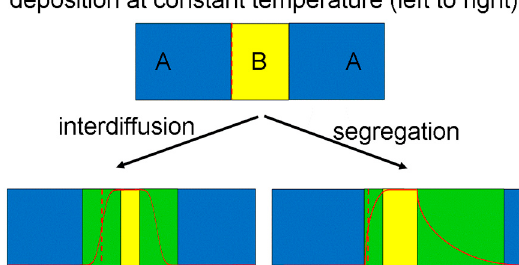
Figure 4. Sketch distinguishing effects of diffusion and segregation for quantum wells. Green is again used to denote a mixed alloy, and the solid red line sketches a line profile of the chemical contribution of component B. The dashed vertical red line indicates an alloy composition of A 0.5 B 0.5 .